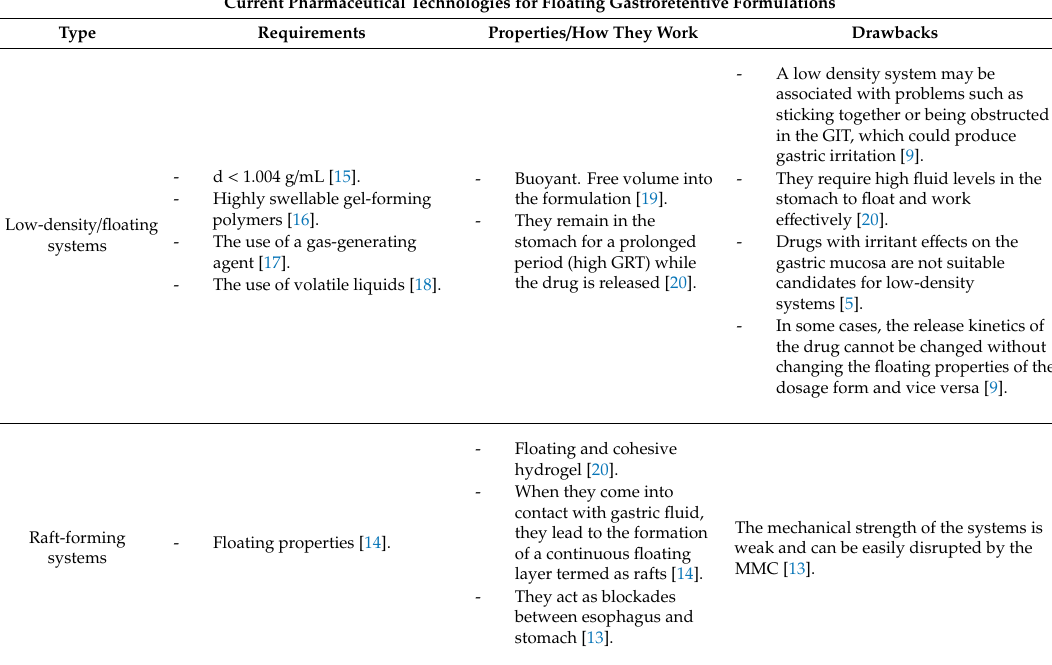
Table 1. Properties, requirements and drawbacks of current pharmaceutical technologies for floating gastroretentive